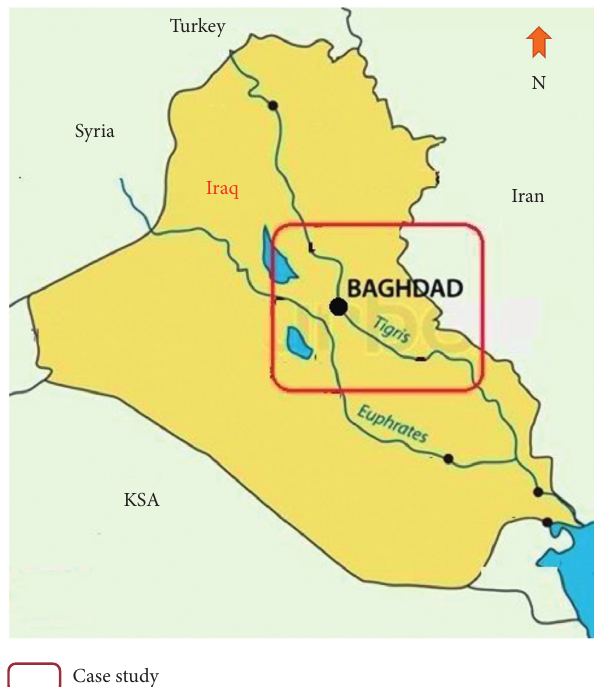
Figure 5: The case study location: Baghdad metrological station, Tigris river, Iraq. Table 1: Descriptive statistics for the mean monthly river flow for the Tigris river at Baghdad (Iraq) (1991–2010) [33]. Partition Time